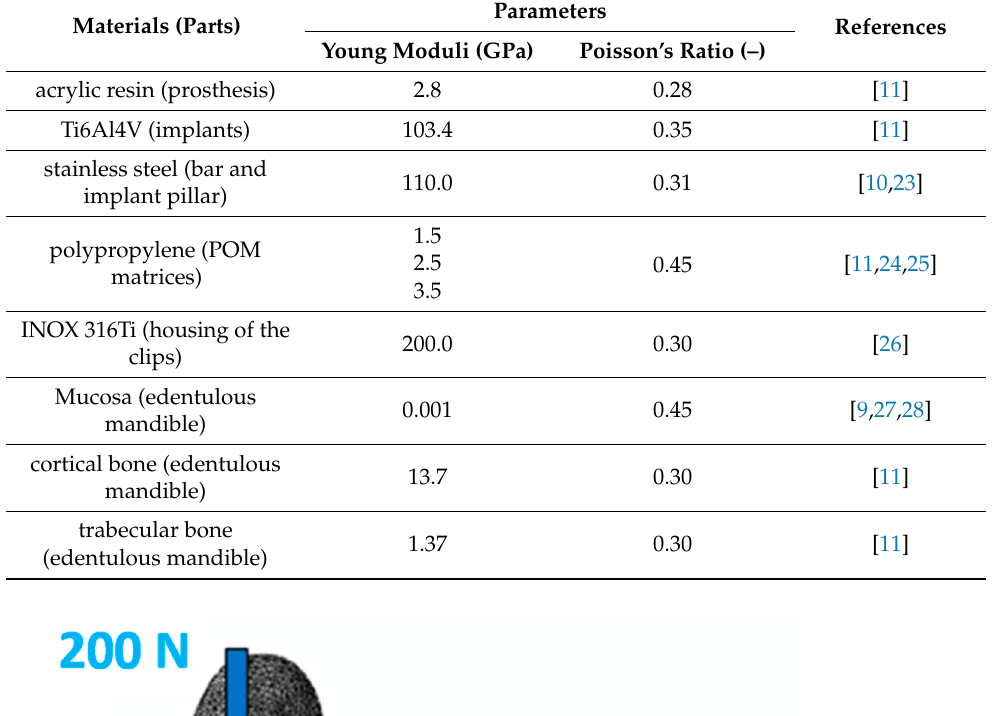
Table 1. Mechanical properties of the materials.